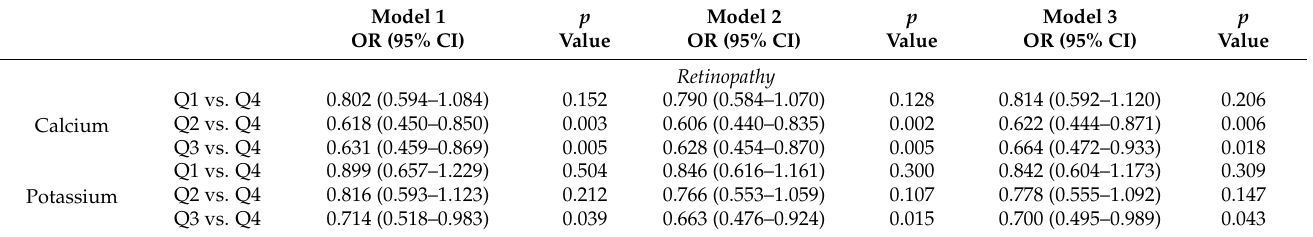
Table 2. Association between quartiles of calcium and potassium and the presence of diabetic retinopathy. Model 1 OR (95%